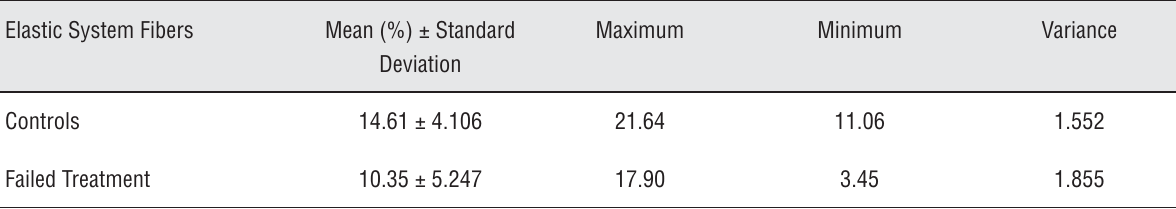
p = 0.056; not signifi cant.